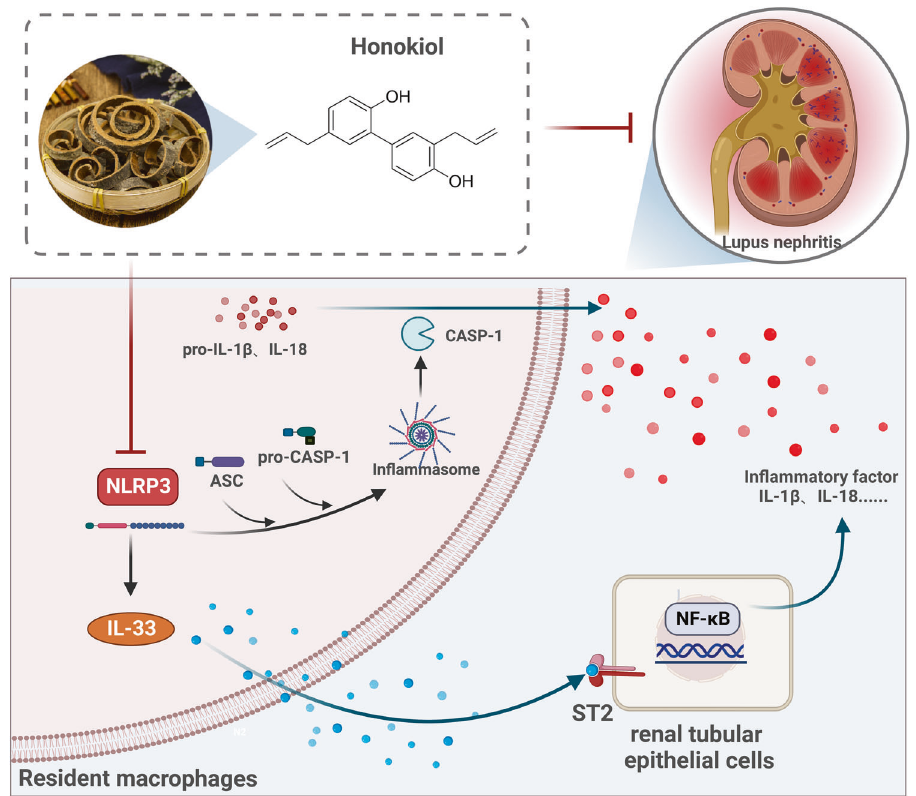
Fig. 8 The mechanism underlying the therapeutic effect of Honokiol (HNK) against lupus nephritis. HNK decreased renal in fl ammation in the kidney by inhibiting the NLRP3/IL-33/ST2 pathway. Created using